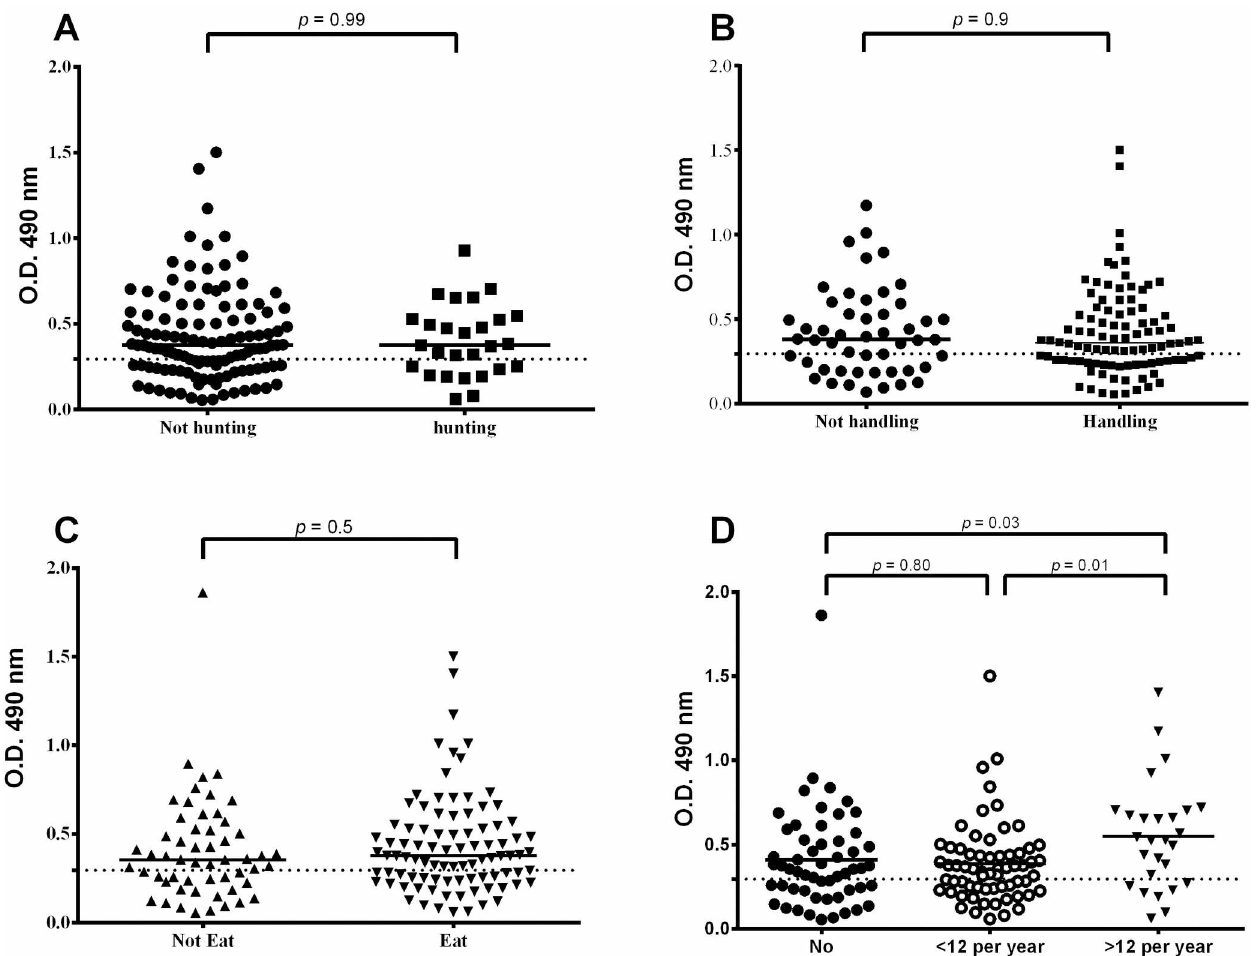
Fig 6. Analysis of anti-PGL-I ELISA titer of 146 individuals based on group behaviors. Behaviors were associated with the type of contact with armadillos, including A) hunting armadillos in the forest, B) handling or preparing armadillo meat for cooking or consumption, C) eating armadillo meat and D) frequency of consuming armadillos in the